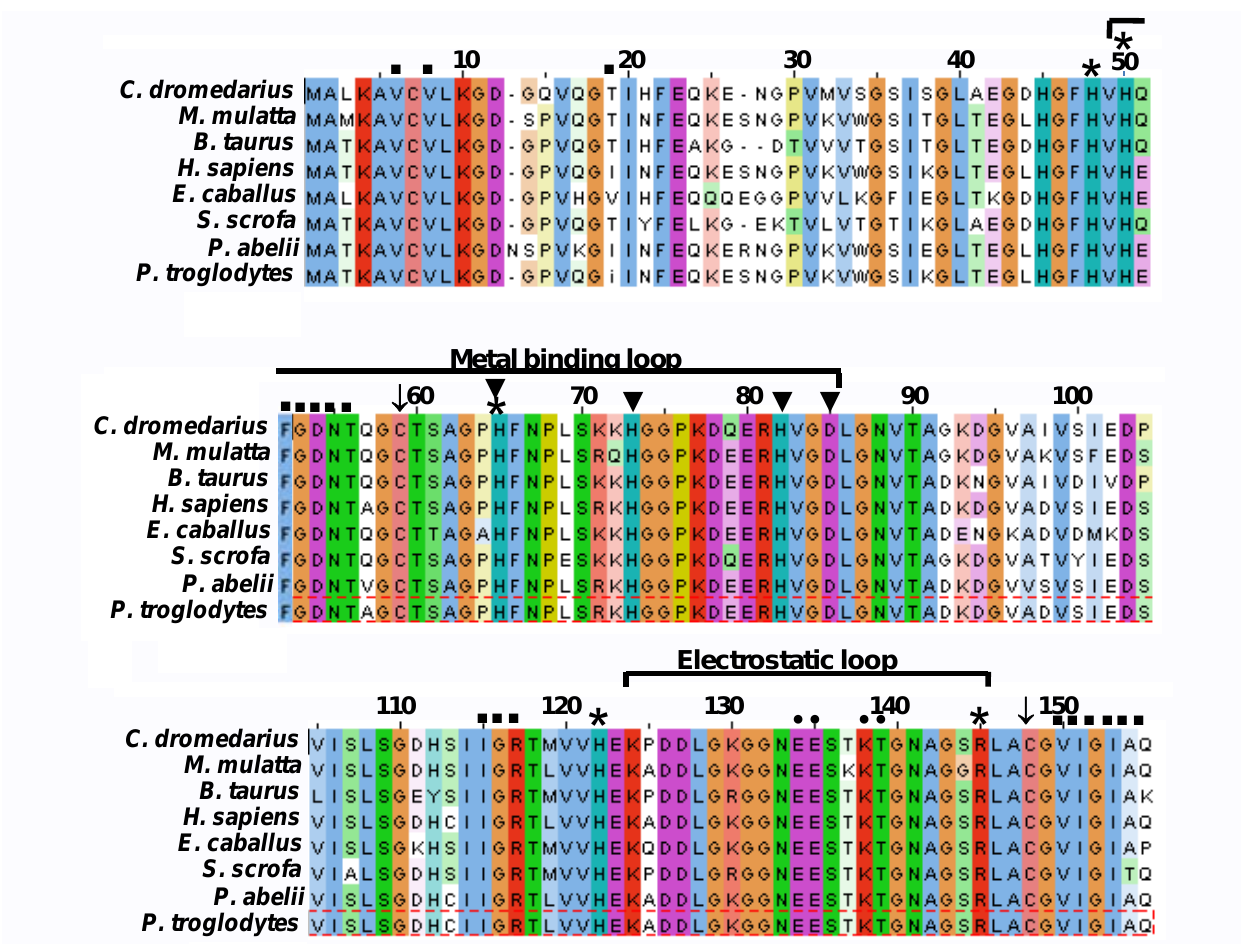
Figure 3. Amino acid sequence alignment of cSOD1 with seven different mammalian proteins. The alignment was generated with the MAFFT Multiple Sequence Alignment program [34]. Residues are color coded according to their conservancy. The Cu and Zn binding site is present on 36 amino acids long stretch of flexible loop. The highly conserved copper binding residues are labeled by ( * ) and zinc binding residues are labeled by ( ▼ ). Conserved His 63 facilitates the binding of both Cu and Zn. Mammalian SOD1 exits as dimer which is formed by hydrophobic (shown by ■ ) and electrostatic (shown by ● )